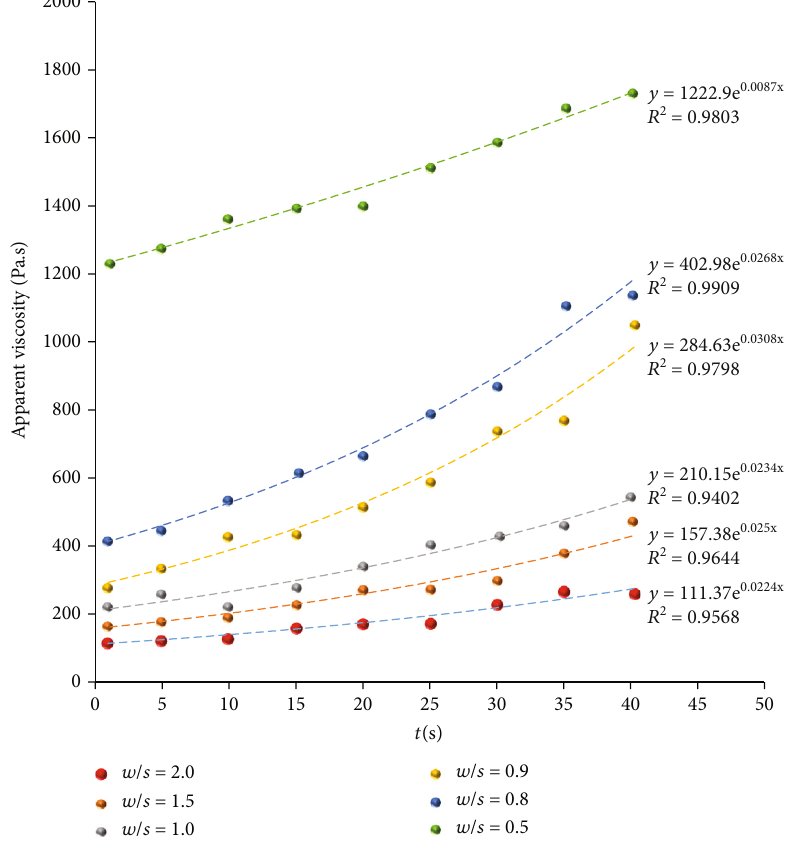
Figure 6: Time-varying curves of viscosity of grout samples with di ff erent water-solid ratios.